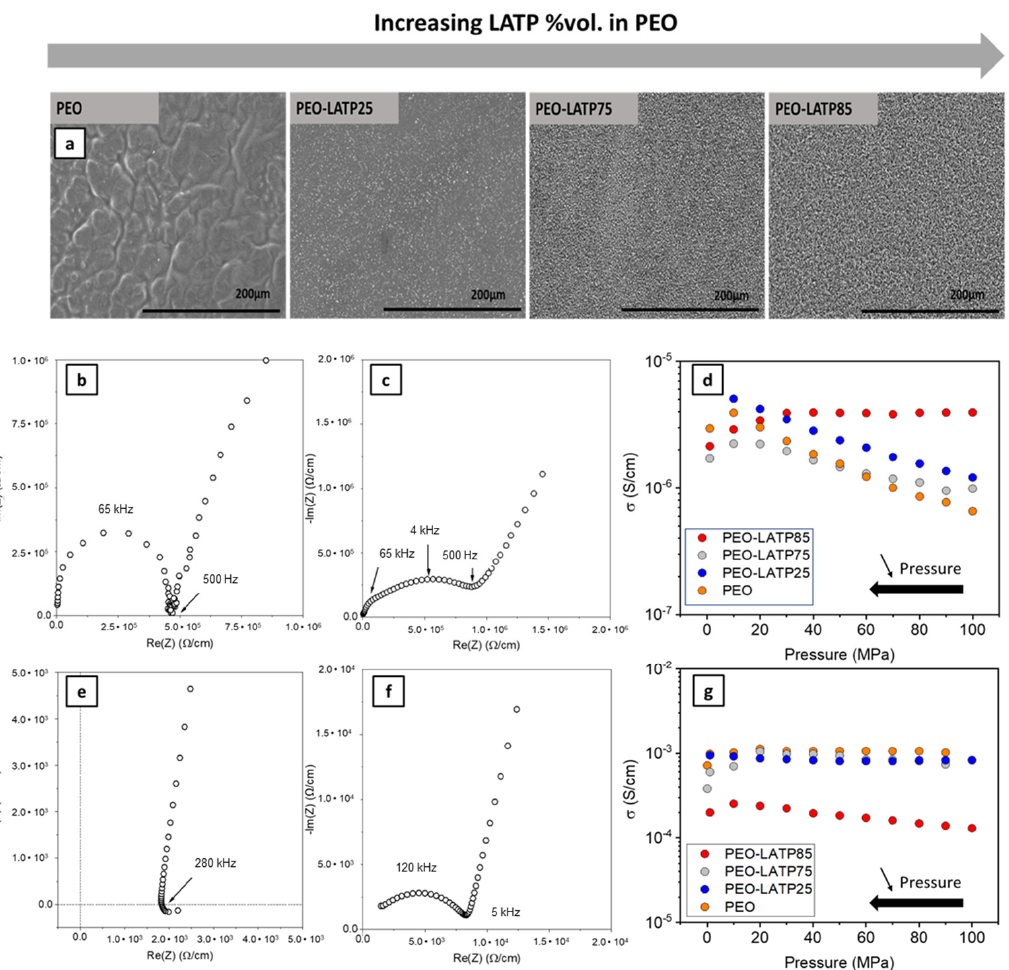
Figure 3. ( a ) SEM images of pure PEO and SCEs, ( b ) EIS diagrams at RT at 20 MPa upon decrease of applied pressure for PEO-LITFSI SPE, ( c ) PEO-LATP85, ( d ) ionic conductivities at RT as a function of the applied pressure for the studied solid electrolyte, ( e ) EIS diagrams at 70 °C at 20 MPa upon decrease of applied pressure for PEO-LITFSI SPE, ( f ) PEO-LATP85, and ( g ) ionic conductivities at 70 °C as a function of the applied pressure for the studied solid electrolytes.